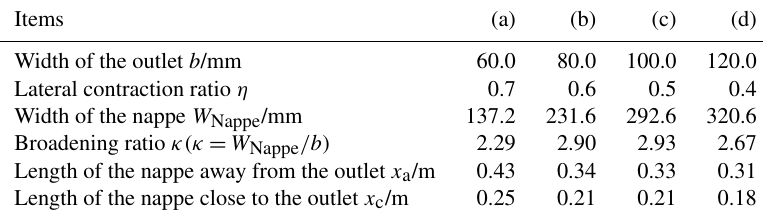
Table 1. The main parameters of the debris flow nappe for different contraction ratios.